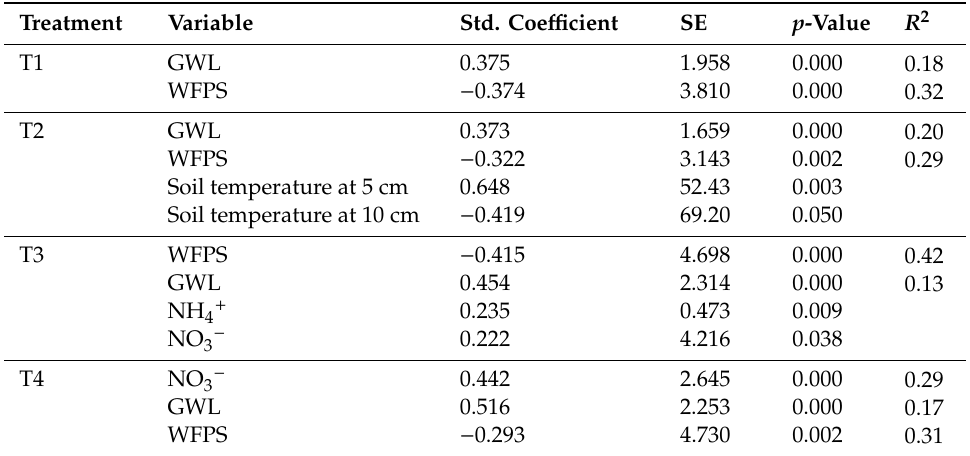
Table 7. The stepwise regression analysis denoting the e ff ect of environmental variables and soil inorganic N on the N 2 O fluxes in each treatment ( n = 72).